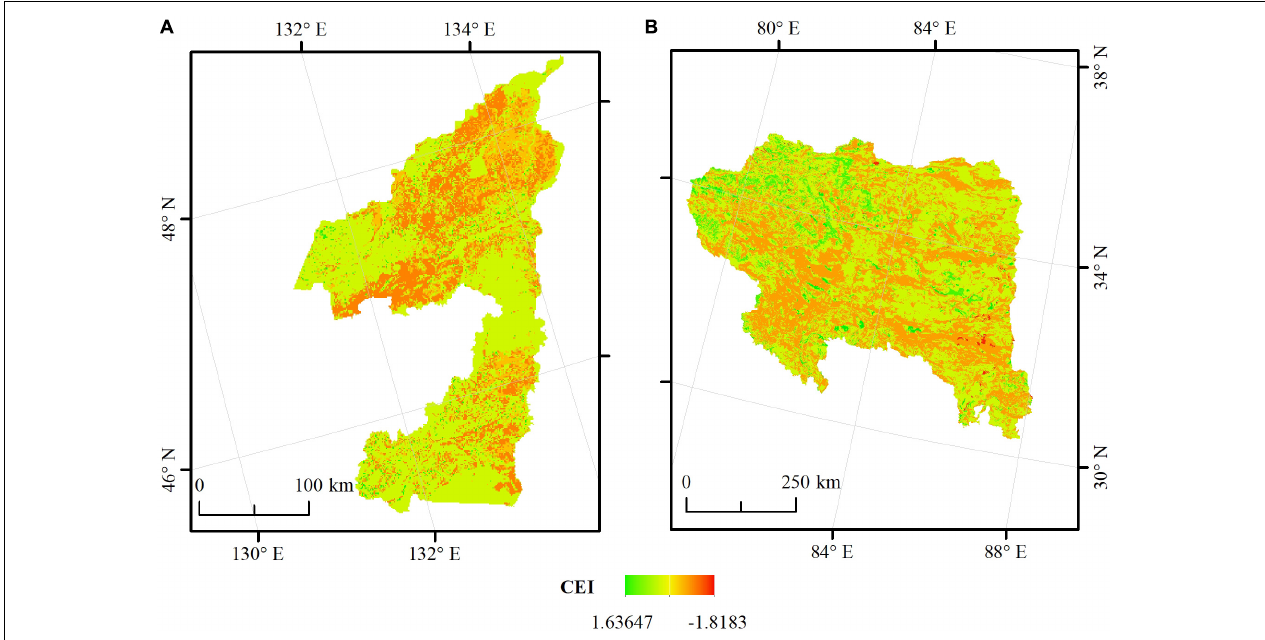
FIGURE 8 | Spatial distribution of CEI in SJPW (A) and NTQTP (B) from